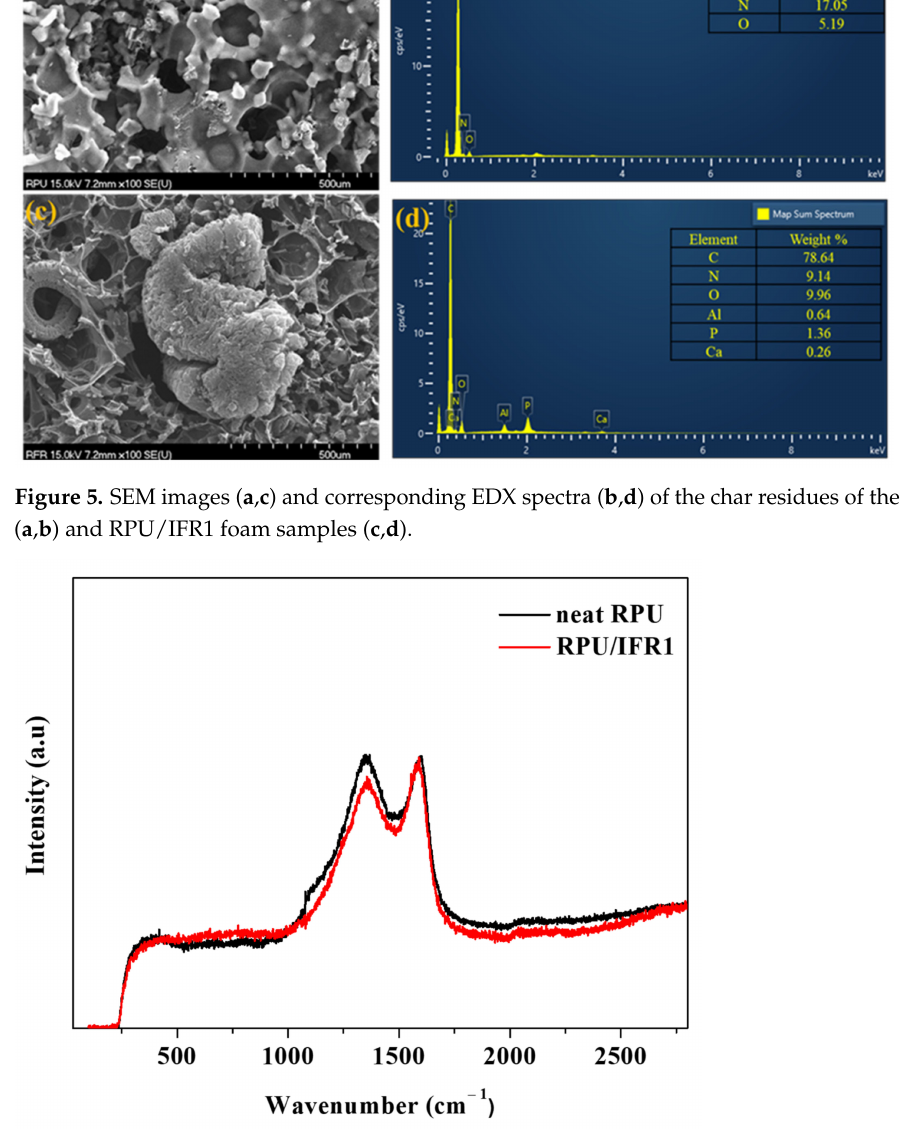
Figure 6. Raman spectra of the char residues collected from neat RPU and RPU/IFR1 foam samples after the